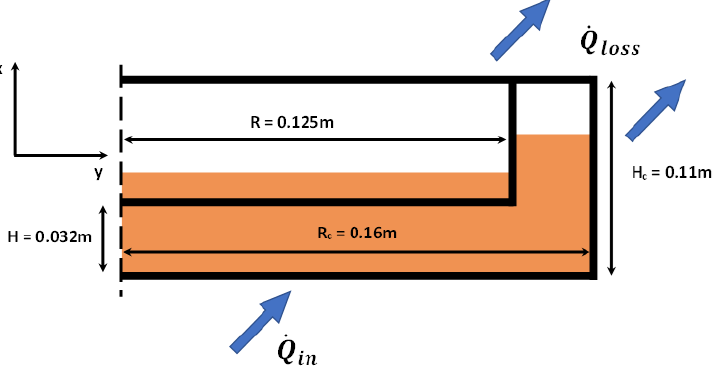
Figure 2. Schematic view of the numerical domain, together with the boundary conditions. The arrows indicate the heat fluxes through the walls.